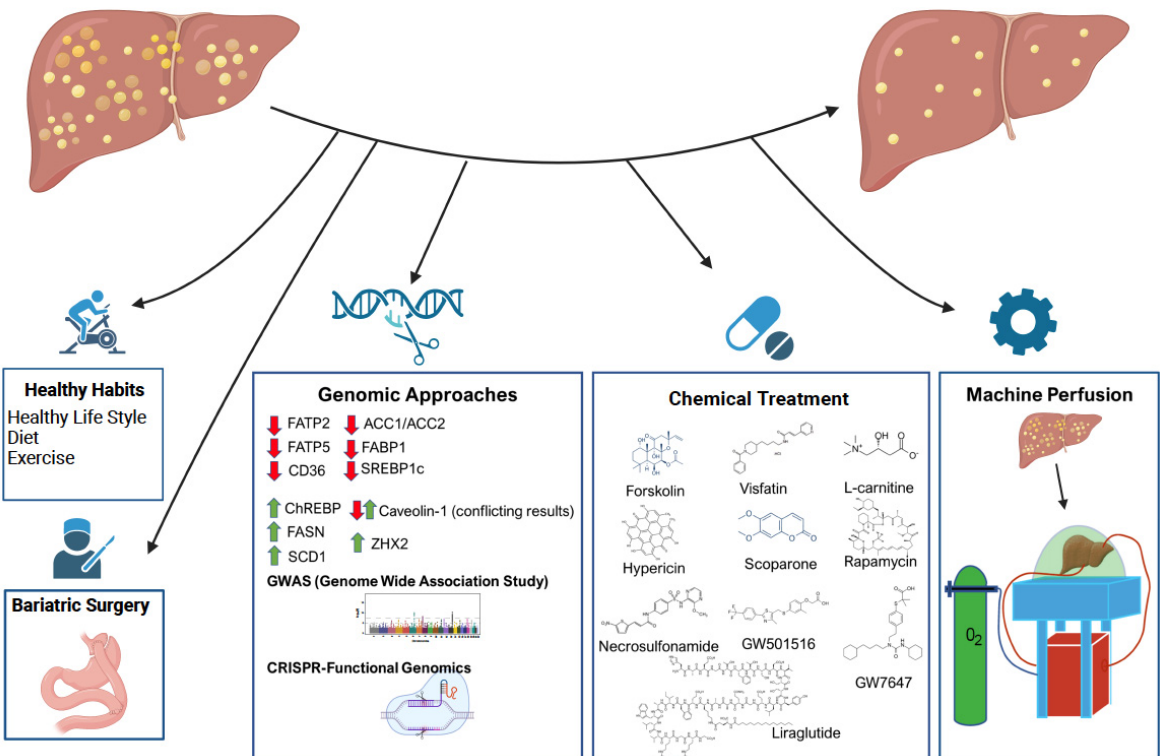
Figure 2. Overview of the different approaches for defatting purposes. Red arrow shows the beneficial effect of down regulation of target genes while green arrow demonstrates the positive effect of upregulation on defatting in third panel. Fourth panel summarizes the structure of known chemicals from in vitro defatting experiment. Perfusion of liver on normo- and hypothermic machine has great premise for future therapeutic approaches ( Created with BioRender.com ).